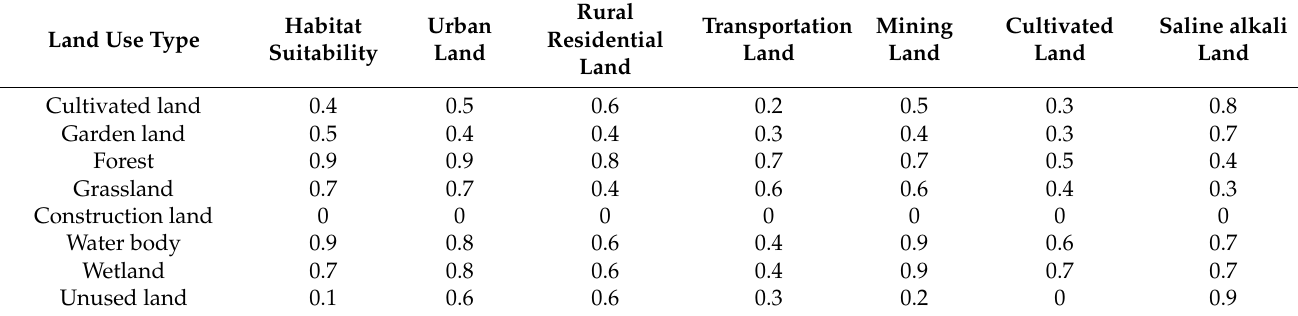
Table 7. The sensitivity of land use to each threat factor in the study